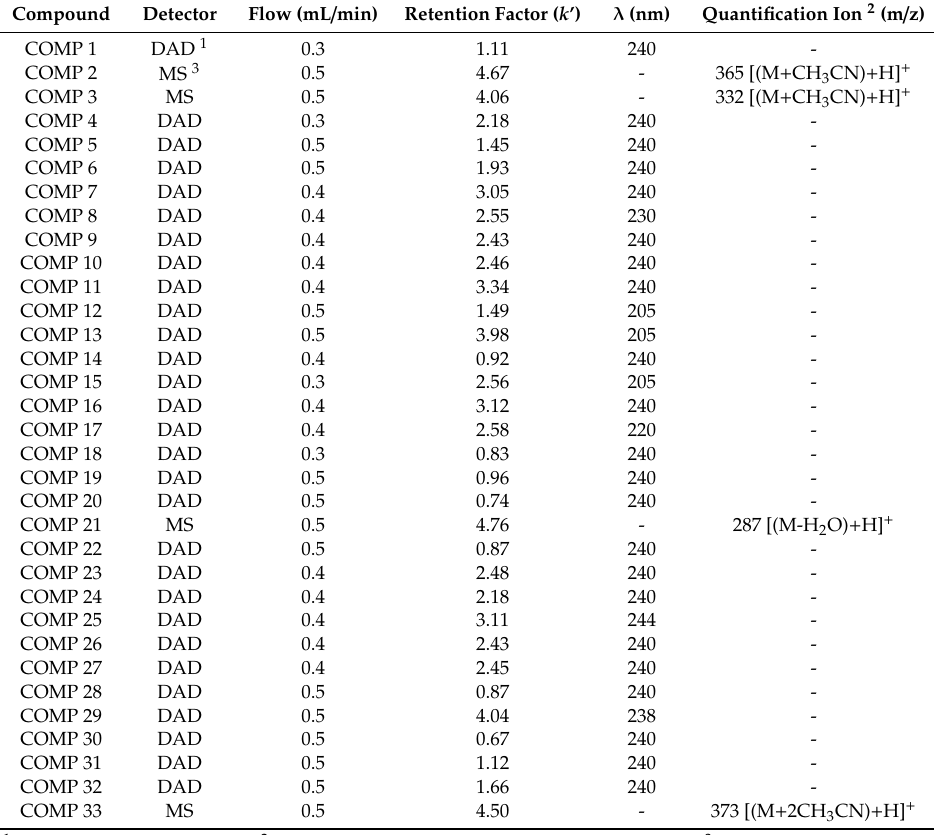
Table 5. Chromatographic